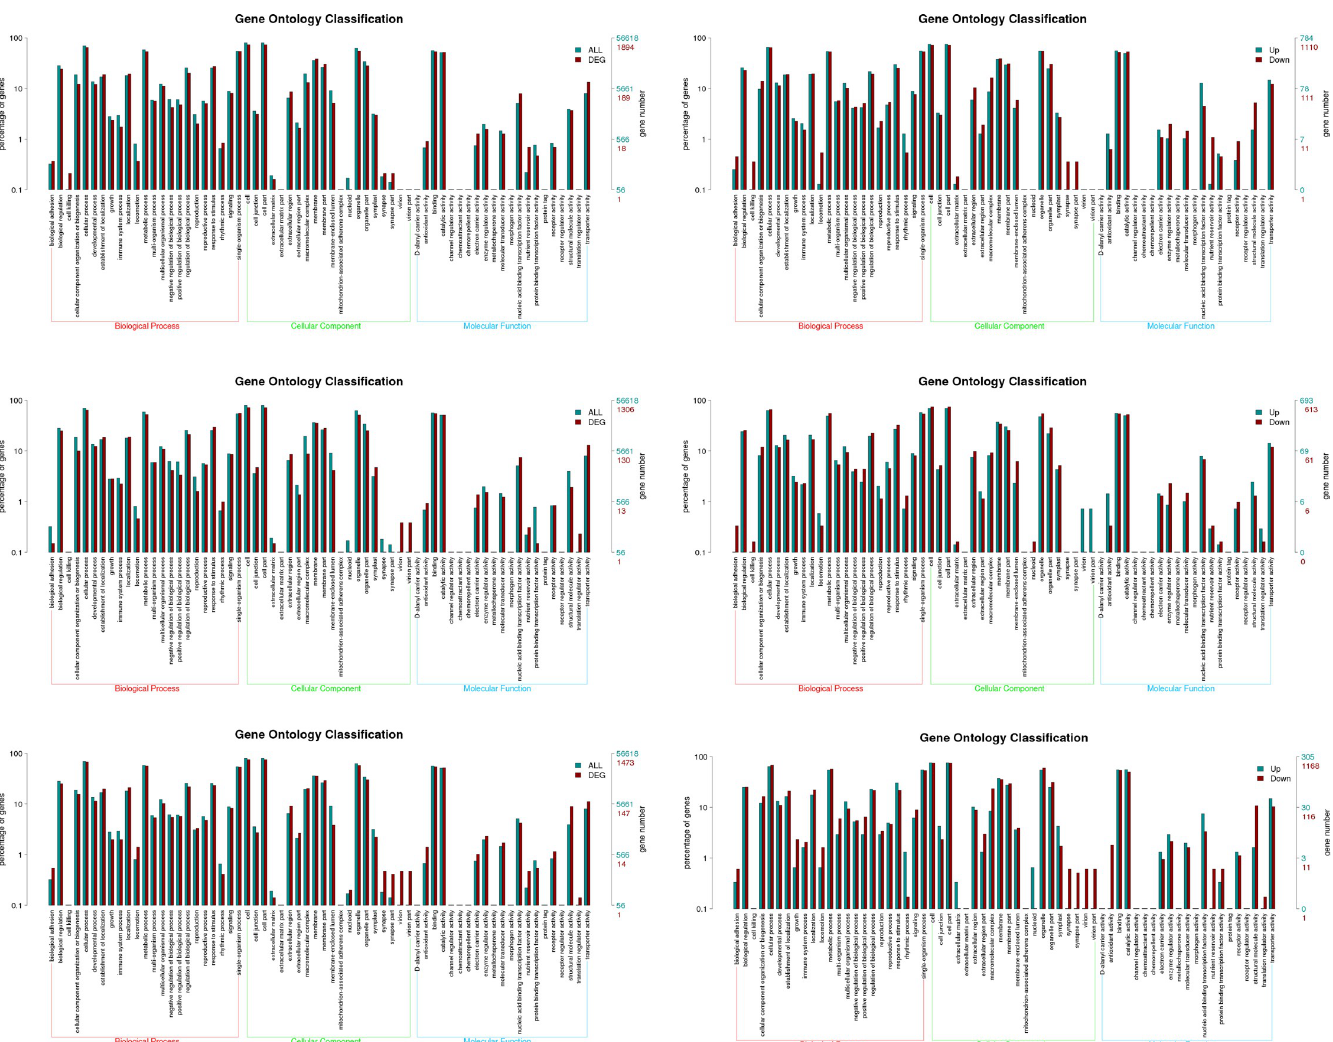
Fig 6. Histogram of GO classification of differentially expressed genes (DEGs) in N0 vs. Nf, Nl vs. Nf, and N0 vs. Nl at 75 days after transplanting (DAT). Blue represents all unigenes annotated in each subcategory, red represents all DEGs annotated in each subcategory. The right y-axis represents the number of genes annotated in each subcategory. The left y-axis represents the percentage of unigenes annotated or DEGs in the main category. (a, b) N0 vs. Nf, (c, d) Nl vs. Nf, (e, f) N0 vs. Nf.